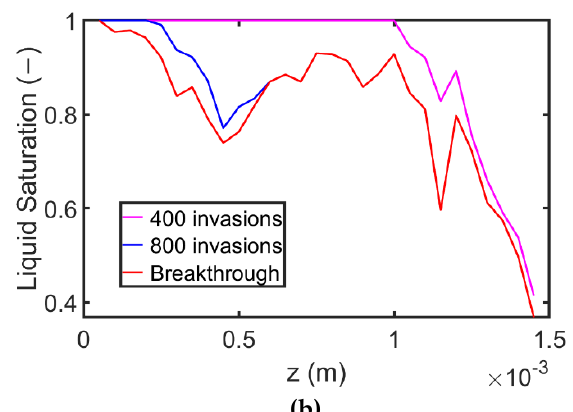
Figure 12. (a ) Exemplary invasion patterns of the monomodal PN with porosity 71%. Liquid in blue, gas in white and solid in gray. The arrow indicates the direction of gas invasion. ( b ) Saturation profiles for different overall number of invaded throats and pores achieved during one drainage simulation of the PN with randomly distributed pore and throat sizes.